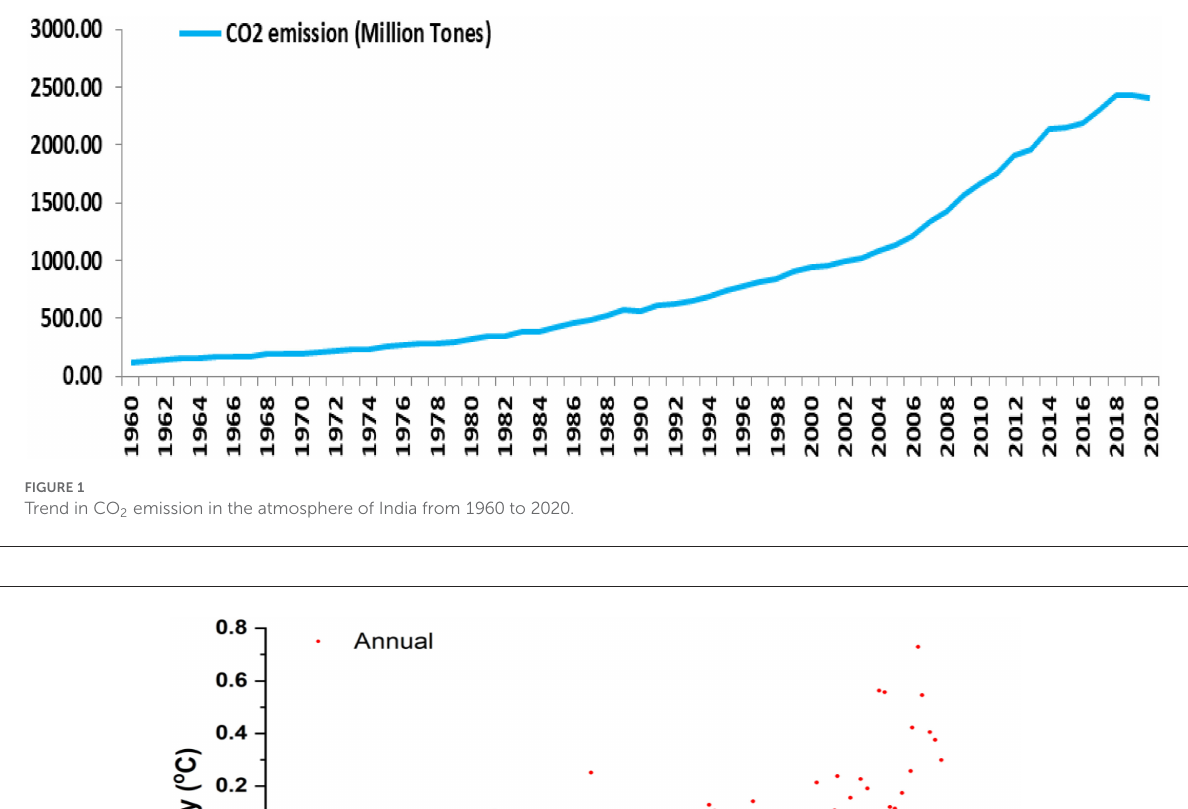
FIGURE1 Trend in CO 2 emission in the atmosphere of India from 1960 to 2020.